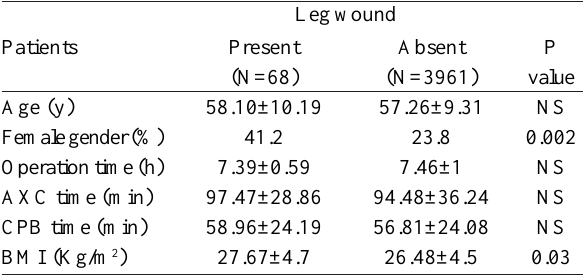
Table 1. Patient demographics